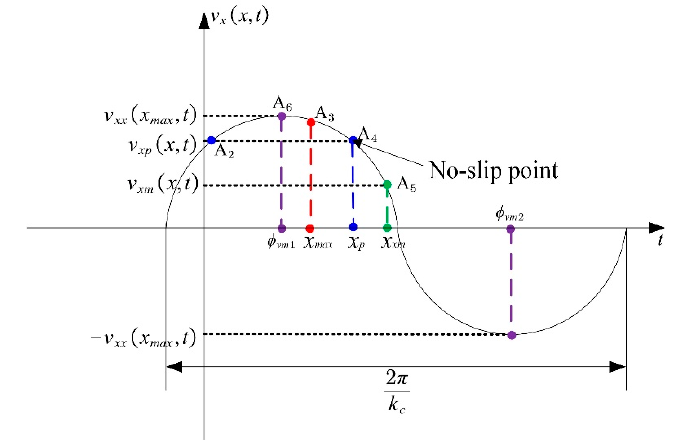
Figure 6. Instantaneous tangential velocity of particle point Q.